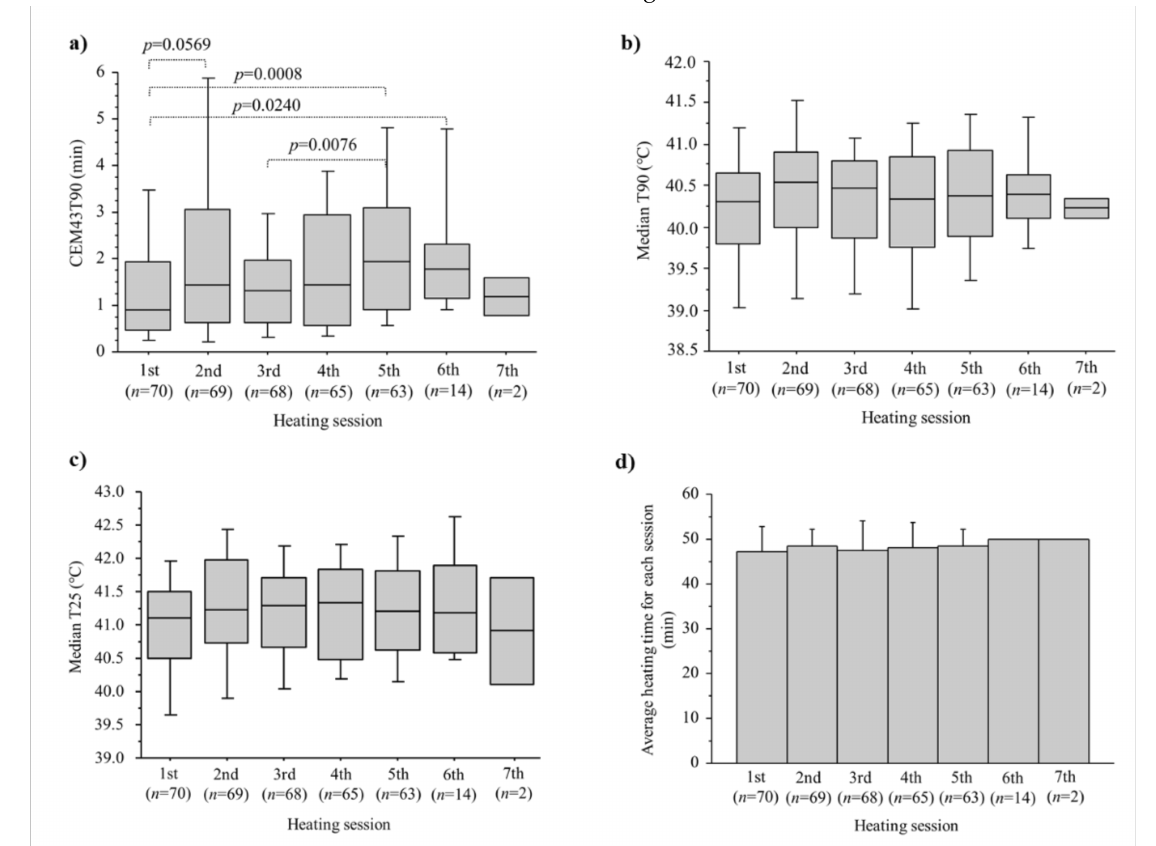
Figure 2. Thermal dose of CEM43T90 ( a ) median T90 ( b ) median T25 ( c ) and heating time ( d ) in each of the HT treatment